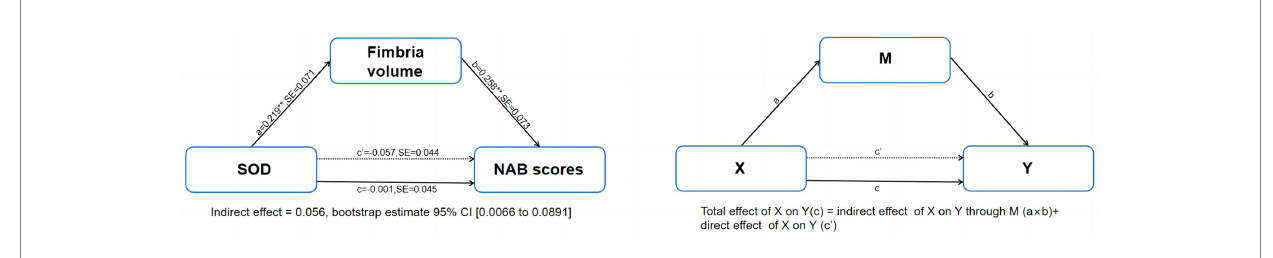
FIGURE 3 Mediation model of the interrelationships among serum levels of SOD, fimbria volume and NAB scores in patients with schizophrenia, controlling for age and sex. NAB, Neuropsychological Assessment Battery; SE, stand error. ** p <